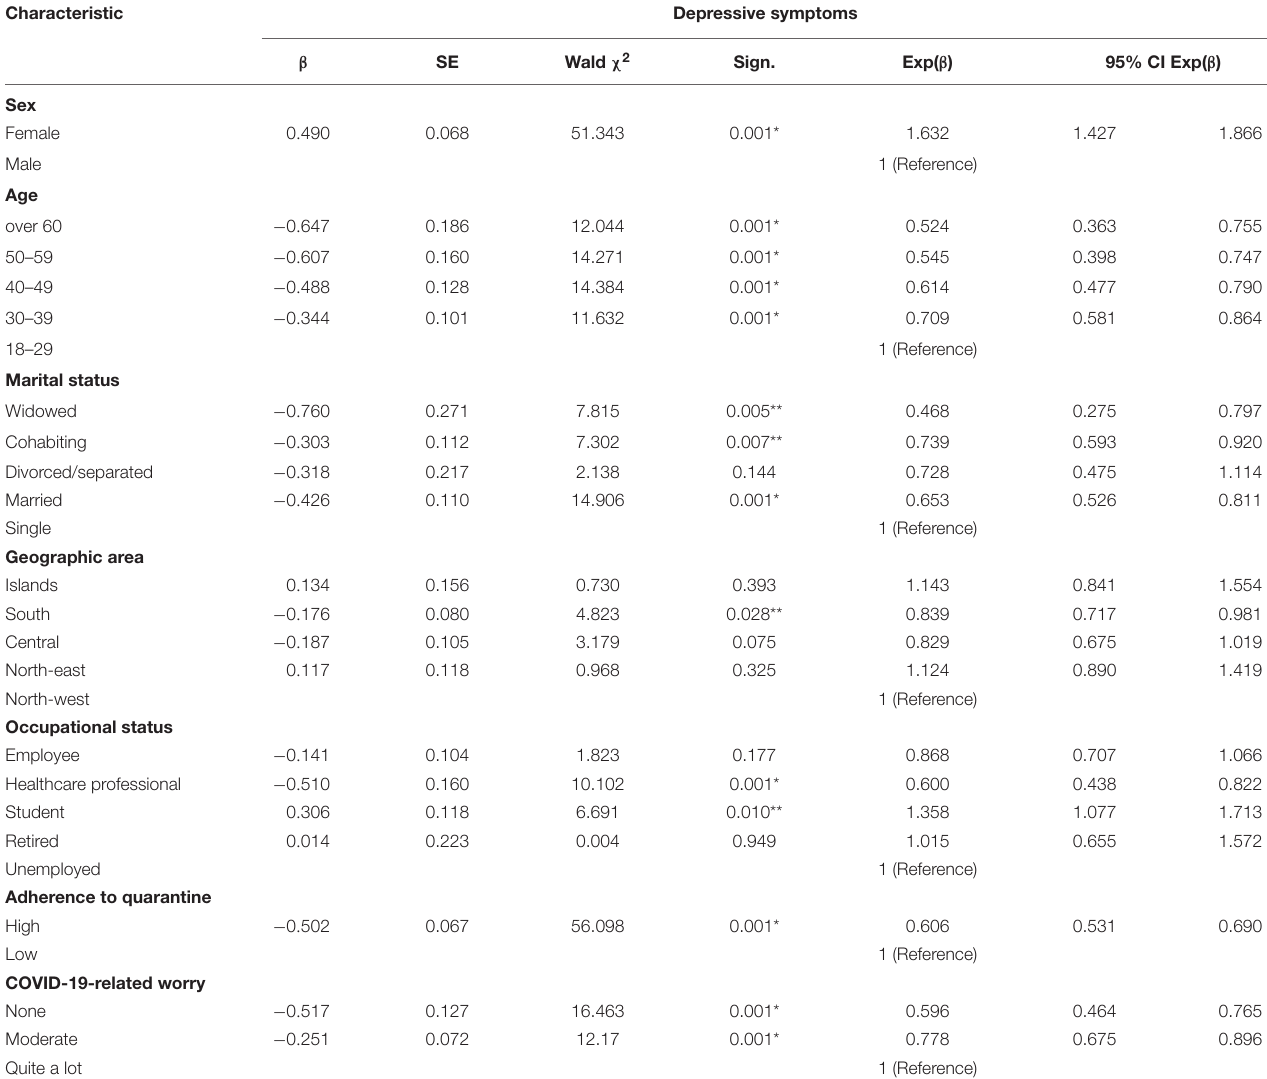
TABLE 4 | Results of GLMs model 1 ( N =